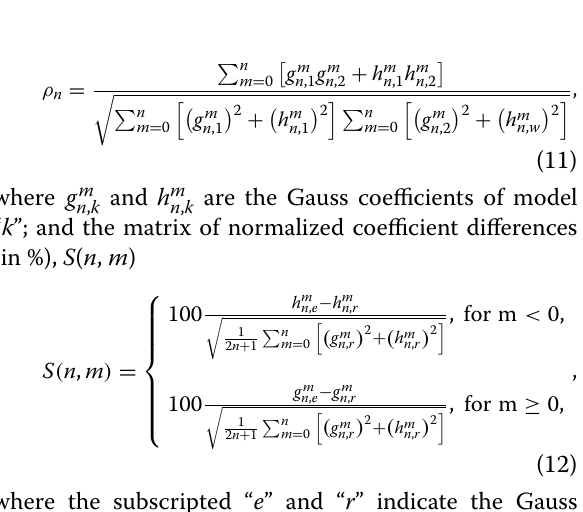
Fig. 2 The core radial magnetic field (left) and associated SV (right) from CM6 (top) and from CM6 minus CHAOS (bottom) for SH degrees n at epoch 2016.0 at the CMB. Note the difference in scales between the top and bottom